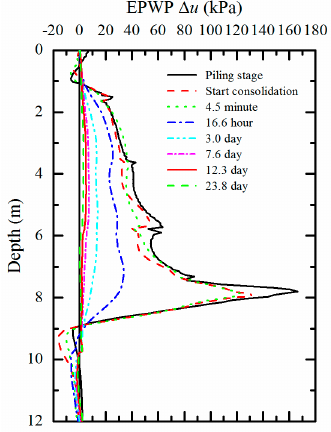
Figure 6. EPWP contours induced by steel-pipe pile jacking during and after pile installation. ( a ) Piling stage; ( b ) Start consolidation; ( c ) 4.5 min; ( d ) 16.6 h; ( e ) 3.0 day; ( f ) 7.6 day; ( g ) 12.3 day; ( h ) 23.8 day.